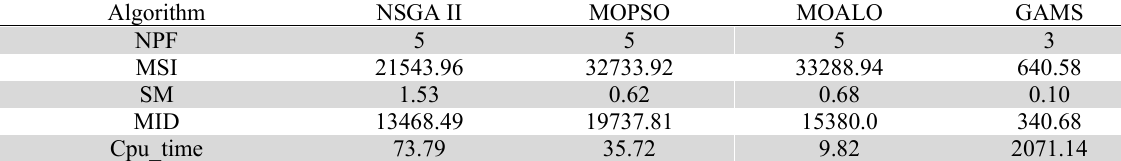
Comparison of solving problem indices in small sample solution